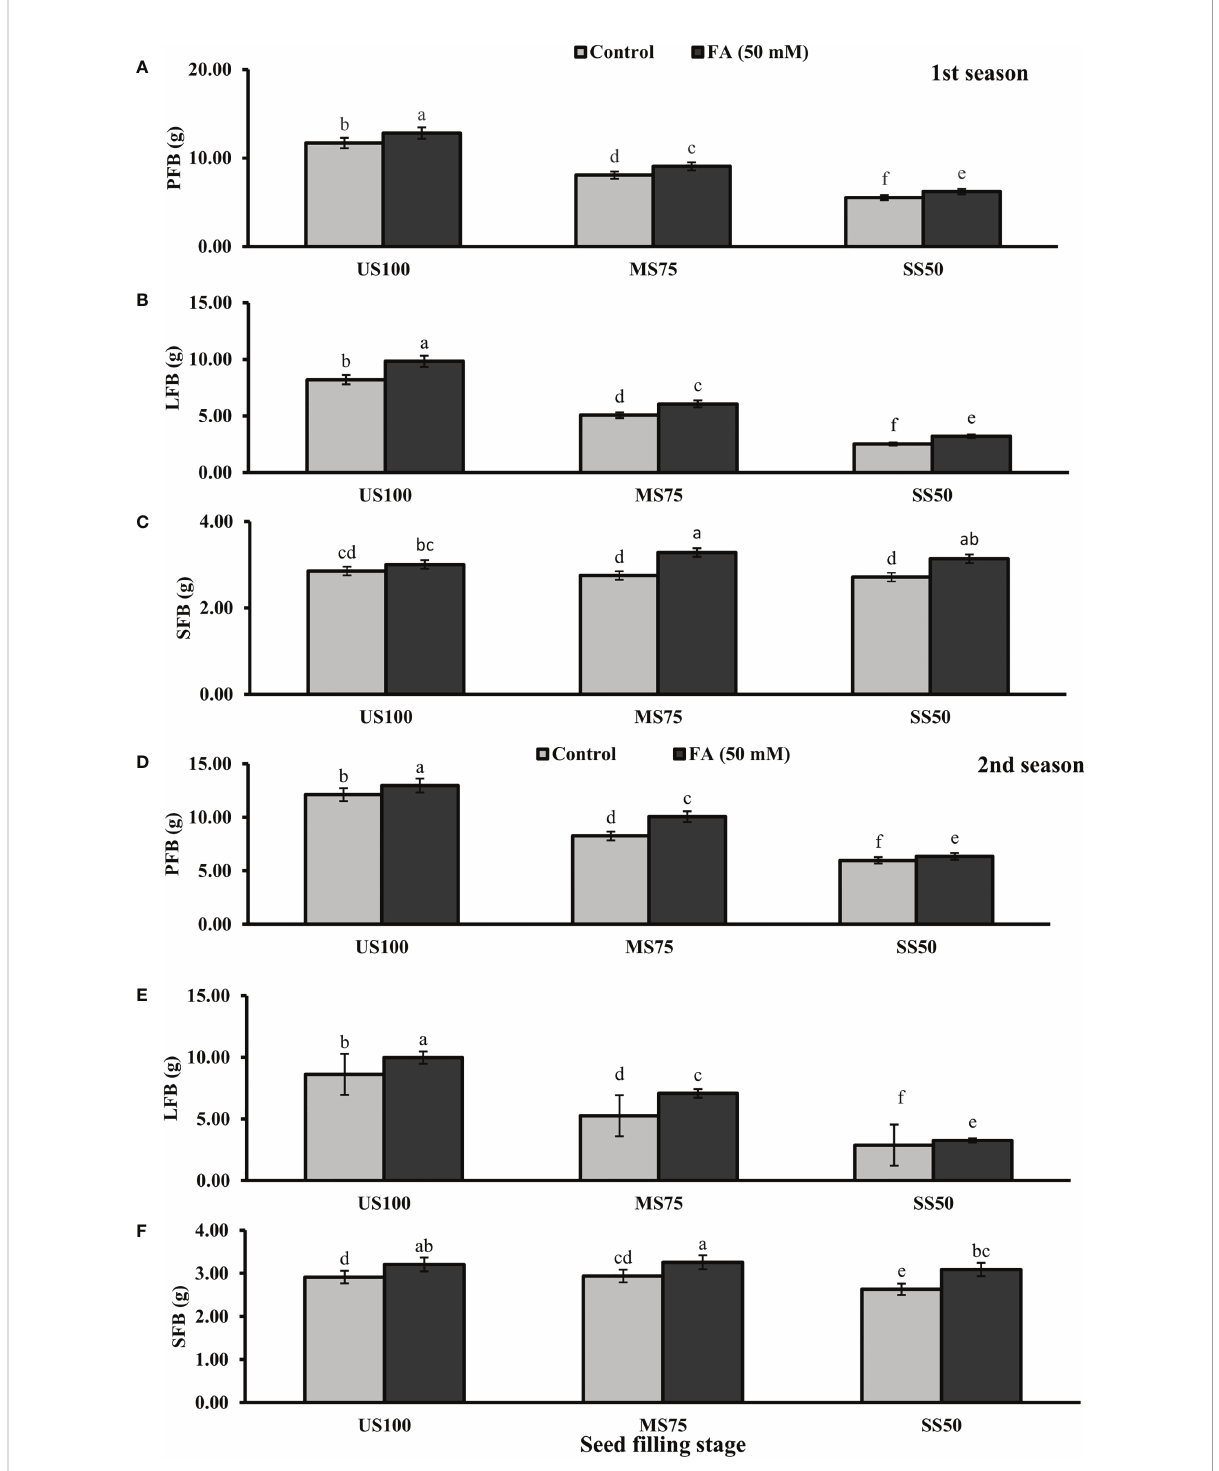
FIGURE 5 Effect of foliar application of folic acid (50 mM) at seed fi lling stage on (A, D) plant fresh biomass/plant, (B, E) leaf fresh biomass/plant, and (C, F) shoot fresh biomass in the fi rst and second seasons. The graph values are the mean ± SE of four replicates. The bars exhibited with different letters indicate a signi fi cant difference between samples by least signi fi cant difference ( p ≤